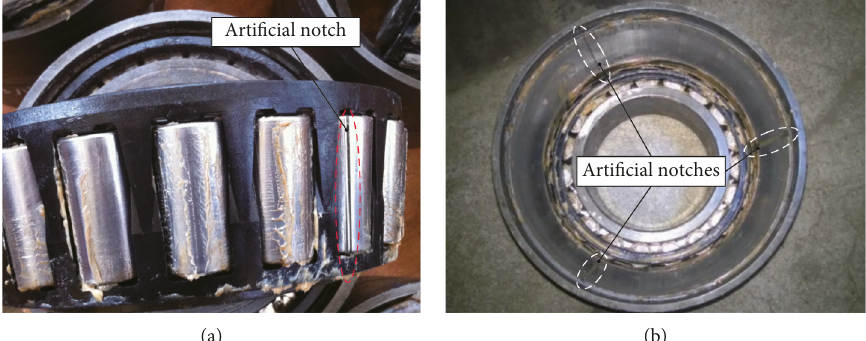
Figure 11: Artificial notches on the surface of the wheelset bearing parts: (a) artificial notches on a roller; (b) artificial notches on the outer